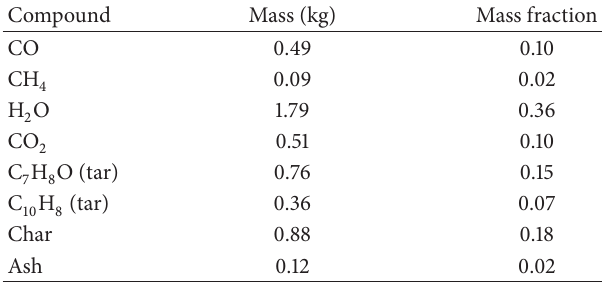
Table 2: Pyrolysis product (fuel decomposition).